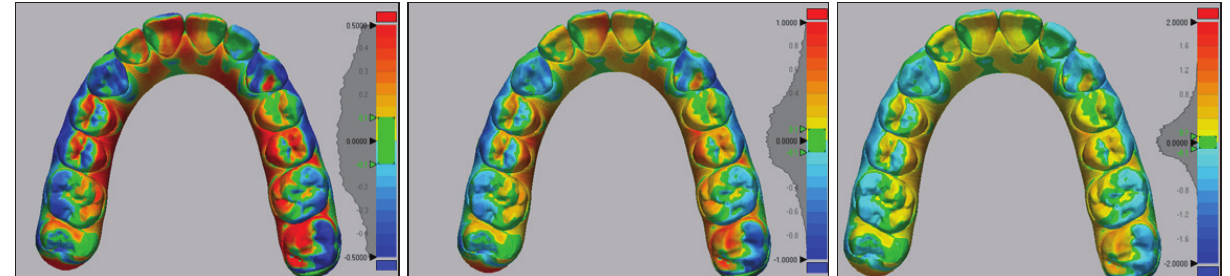
Figure 6. 3D heat map superimposition at different levels of discrimination. 6a: Scale 0.5 mm either side of ideal with 0.05 mm subdivisions. 6b: Scale 1 mm with 0.1 mm subdivisions. 6c: Scale 2 mm with 0.2 mm